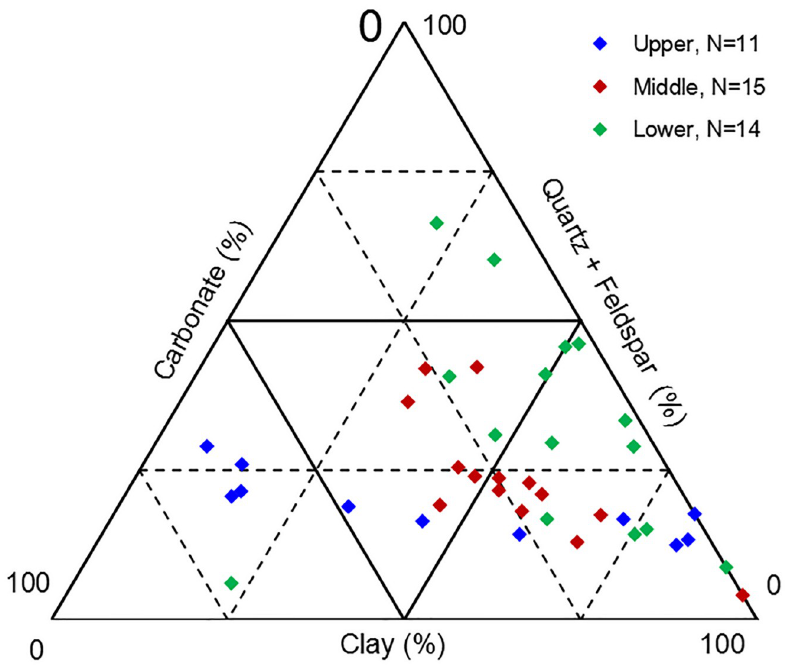
Fig 3. Triangular diagram of mineral composition of Permian Longtan Formation samples from southeastern Sichuan (Note: 25 of these data points from [30]).